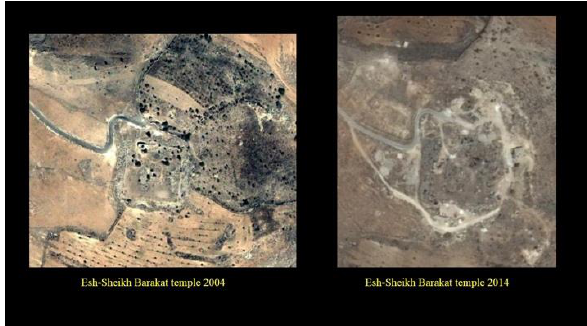
Figure 11. Esh-Sheikh Barakat temple 2004 - 2014.